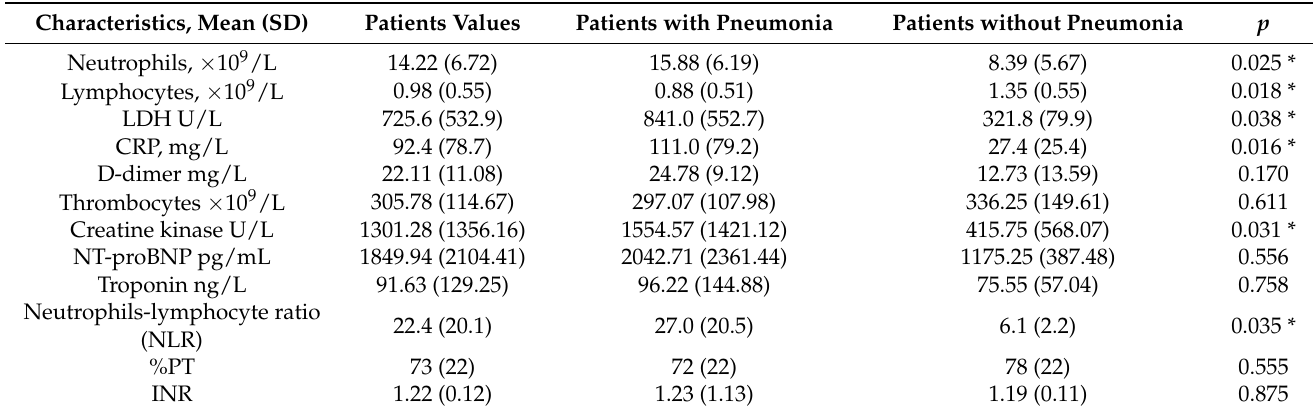
Table 2. Blood parameters on the day of arterial thrombosis signs and symptoms appearing in patients with/without COVID-19